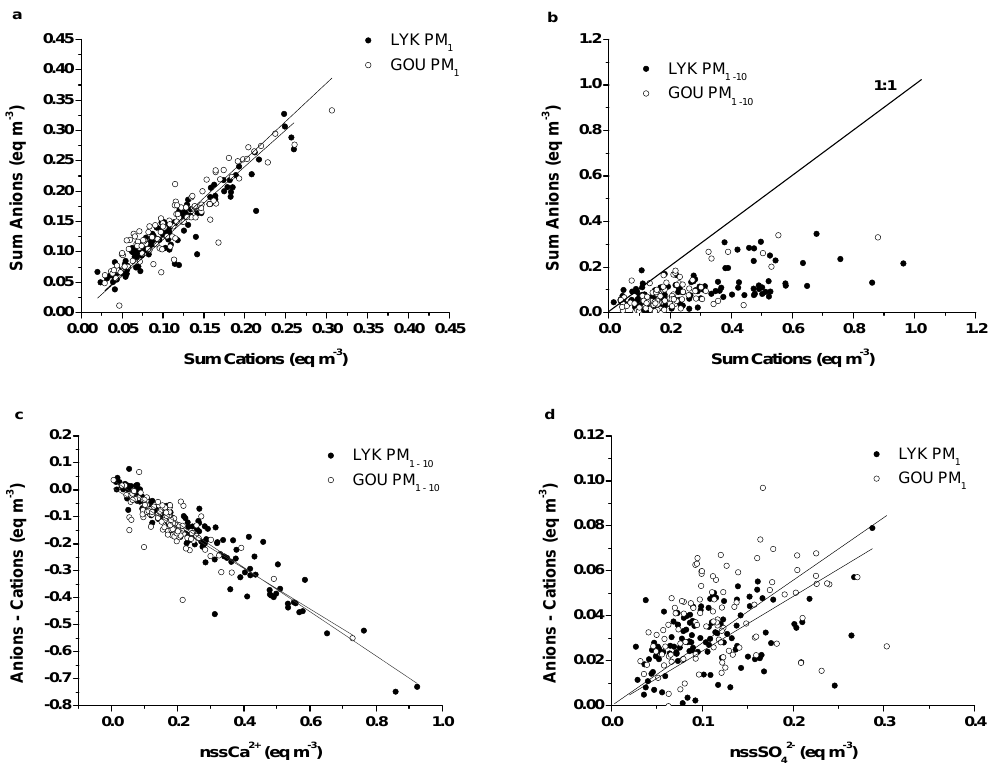
Fig. 7. Ionic balance (eq m − 3 ) for both GAA stations for (a) fine and (b) PM 10 fractions. Anions deficiency versus nssCa 2 + in PM 10 samples (c) and nssSO 2 − in PM 1 samples (d) 4